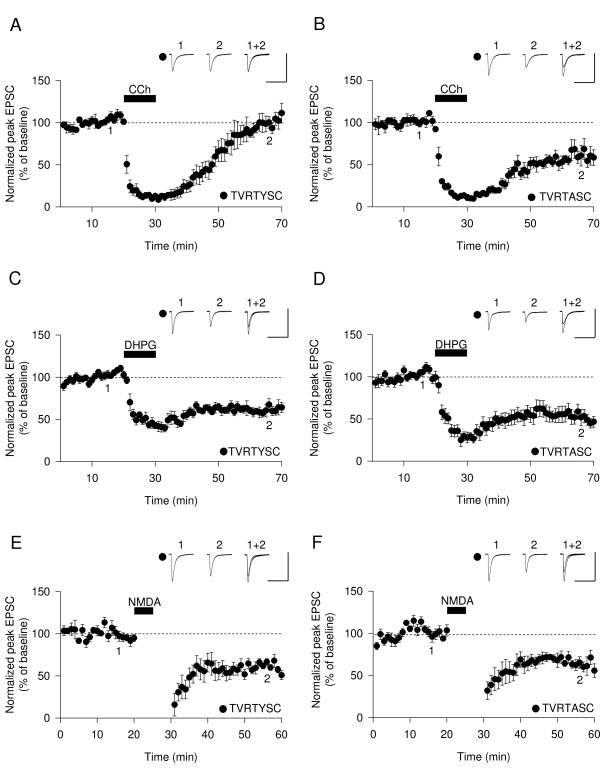
Interaction between liprin α and GRIP is required for mAChR-LTD. (A) Intracellular infusion of the C terminal fragment of liprin α (TVRTYSC) prevents induction of mAChR-LTD (n = 6). (B) A control peptide (TVRTASC) has no affect on mAChR-LTD (n = 5). (C) TVRTYSC (n = 7) has no effect on mGluR-LTD. (D) TVRTASC (n = 8) has no effect on mGluR-LTD. (E) TVRTYSC (n = 6) has no effect on NMDAR-LTD. (F) TVRTASC (n = 6) has no effect on NMDAR-LTD.